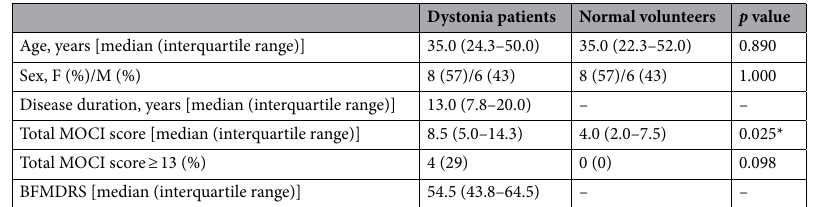
Table 1. Comparisons between the characteristics of patients with dystonia and normal volunteers. A p value < 0.05 is statistically significant. BFMDRS, Burke–Fahn–Marsden Dystonia Rating Scale; F, female; M, male; MOCI, Maudsley Obsessional Compulsive